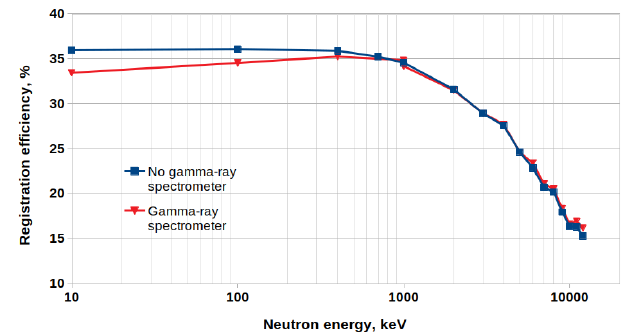
Fig. 7. Expected efficiency for 40 neutron counters based on Monte Carlo simulations corrected by measurements with 252